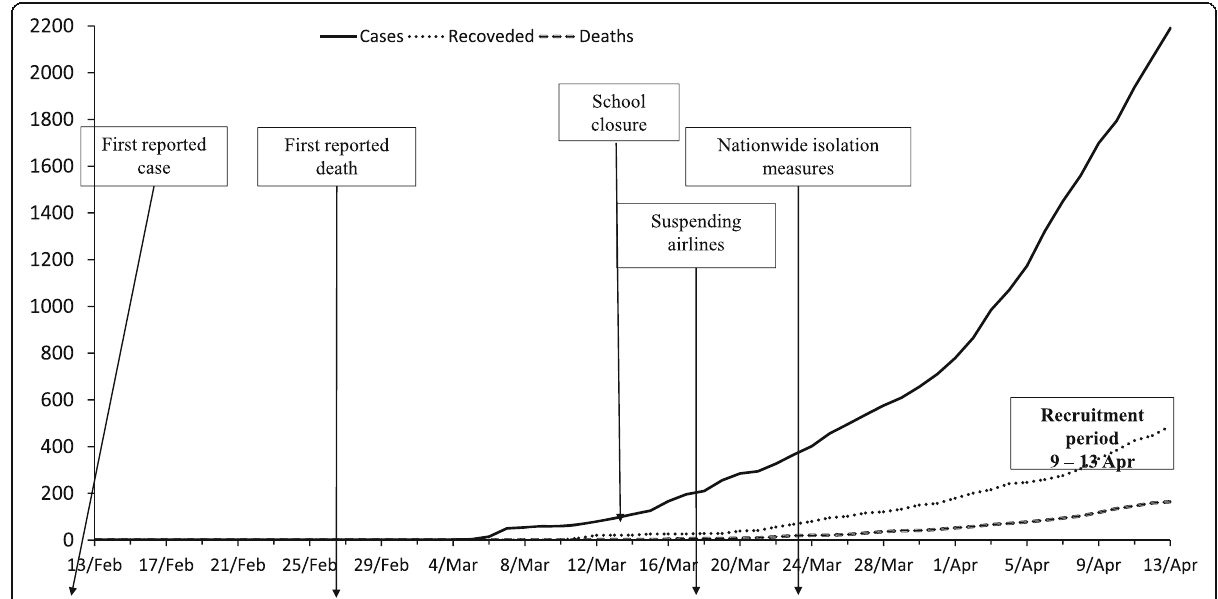
Fig. 1 National trend of the 2019 coronavirus disease (COVID-19) outbreak in Egypt from 13 February to 13 April 2020. The recruitment of participants took place from 9 ‑ 13